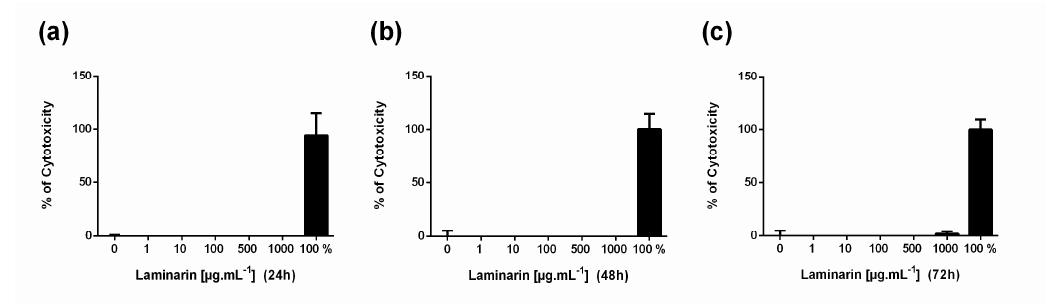
Figure A1. Evaluation of cell metabolic activity by the MTT assay. HaCaT were stimulate with 1, 10, 100, 500 and 1000 µg.mL − 1 laminarin for ( a ) 24 h, ( b ) and (c) 72 h, and cell viability was performed using a tetrasodium salt (MTT). Data are expressed as mean ± SD of three independent experiments. * p ≤ 0.05, **** p ≤ 0.0001 compared with 0 µg.mL − 1 (control group). Cosmetics 2020 , 7 , x FOR PEER REVIEW